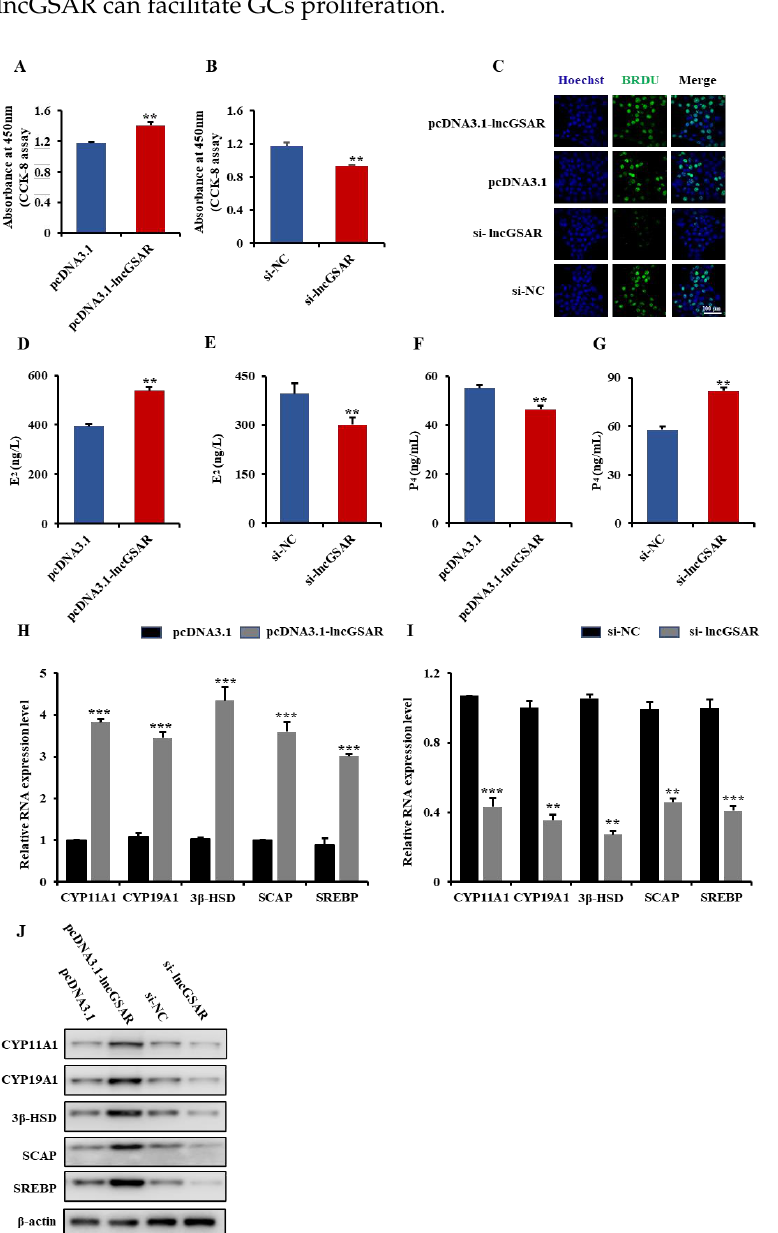
Figure 3. LncGSAR promotes GCs steroidogenesis and proliferation. ( A , B ) CCK-8 assay was per- formed to assess the effect of lncGSAR overexpression and knockdown on GCs proliferation. ( C ) The 5 (cid:48) -bromo-2 (cid:48) -deoxyuridine (BrdU) analysis after transfection of pcDNA3.1-lncGSAR and pcDNA3.1 empty plasmids, i.e., si-lncGSAR and si-NC, in proliferating GCs; scale bars are 100 µ m. ( D , E ) Deter- mination of estradiol (E 2 ) concentrations in GCs transfected with pcDNA3.1-lncGSAR and pcDNA3.1 empty plasmids, i.e., si-lncGSAR and si-NC. ( F , G ) The progesterone (P 4 ) concentrations in GCs after transfection of pcDNA3.1-lncGSAR and pcDNA3.1 empty plasmids or si-lncGSAR and si-NC. ( H , I ) The qRT-PCR of relative expression levels of steroidogenesis-related (CYP11A1, CYP19A1, and 3 β -HSD) and sterol regulation-related (SCAP and SREBP) mRNAs in GCs transfected with pcDNA3.1-lncGSAR and in GCs transfected with si-lncGSAR. ( J ) Overexpression and knockdown of lncGSAR affected the expression of steroidogenesis-related proteins and sterol regulatory element proteins. Values represent means ± SEM for three individuals. ** p < 0.01; *** p <